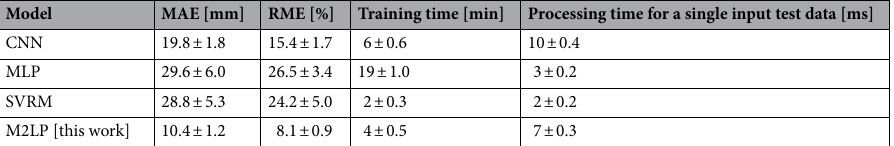
Table 4. Performance metrics and the training time of the proposed and the benchmark models, averaged with standard deviation over ten independent runs. The models trained using the dataset DS4 (500 samples).